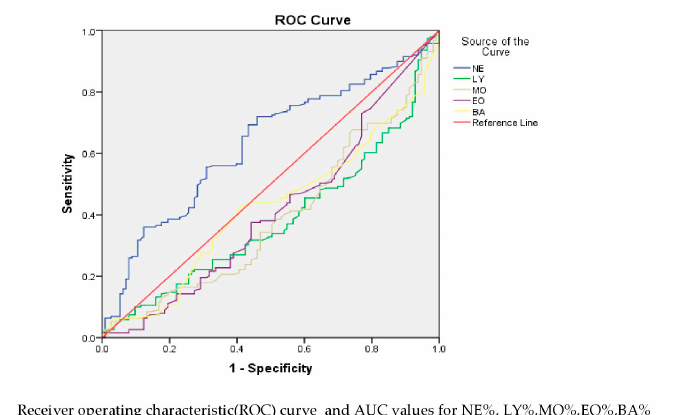
Figure 1. ROC curve for COVID-19 against healthy controls.